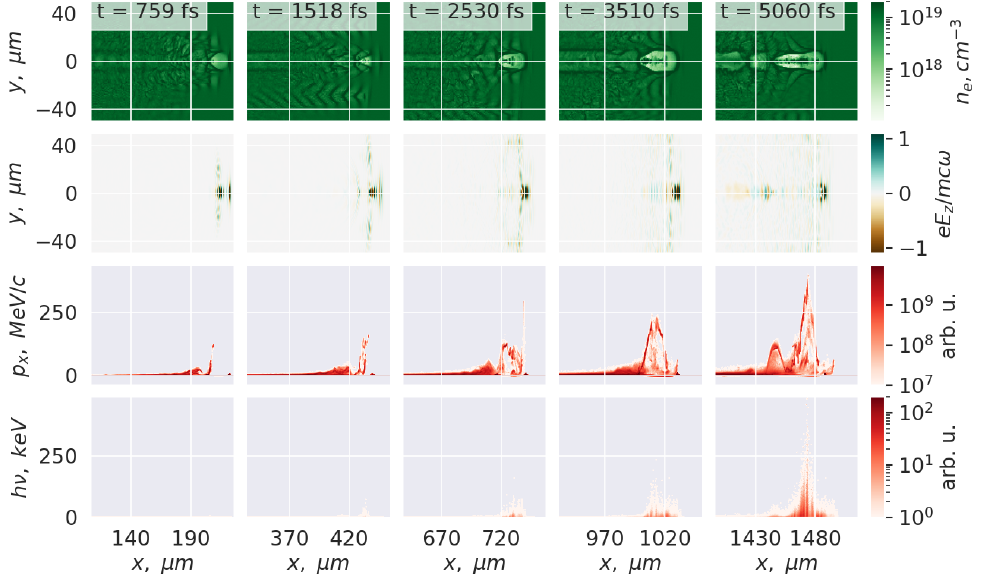
Figure 7. Simulation results for a Gaussian laser pulse with a duration of 11 fs with a 5-fs prepulse. The amplitude of the main pulse is a 0 = 6.5 and the amplitude of the prepulse is a 0 = 3.6. The data shown is similar to Figure